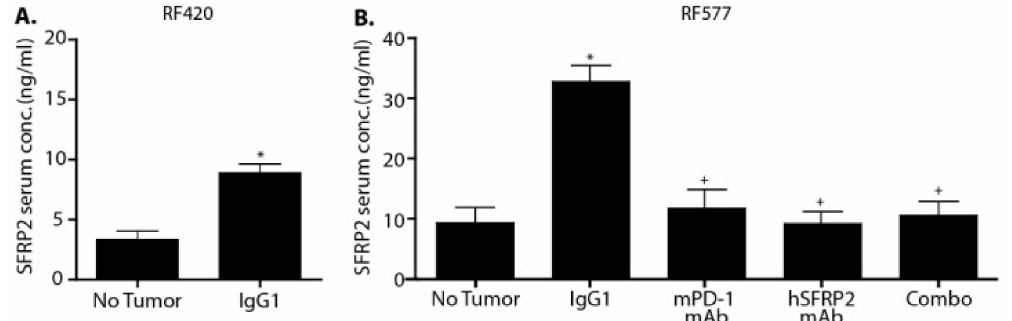
Figure 3. Serum SFRP2 levels are elevated in mice with metastatic osteosarcoma compared to non-tumor-bearing mice and responds to therapy. ( A ) Serum levels of SFRP2 were compared between C57BL/6 mice with metastatic RF420 OS treated with IgG1 control and non-tumor-bearing C57BL/6 mice with ELISA. There were significantly higher levels of SFRP2 in the serum of mice with metastatic RF420 OS versus mice without tumors ( n = 3, * p < 0.01). ( B ) ELISA was used to compare the serum levels of SFRP2 in all treatment groups of the C57BL/6 mice with metastatic RF577 OS and C57BL/6 mice without tumors. The serum level of SFRP2 was significantly higher in the group of tumor-bearing mice treated with IgG1 compared to non-tumor-bearing mice (* p < 0.01) ( n = 9 and n = 8, respectively). The serum level of SFRP2 was significantly decreased in the mPD-1 mAb ( n = 8), hSFRP2 mAb ( n = 12) and Combo ( n = 12) treatment groups compared to IgG1-treated mice ( + p <